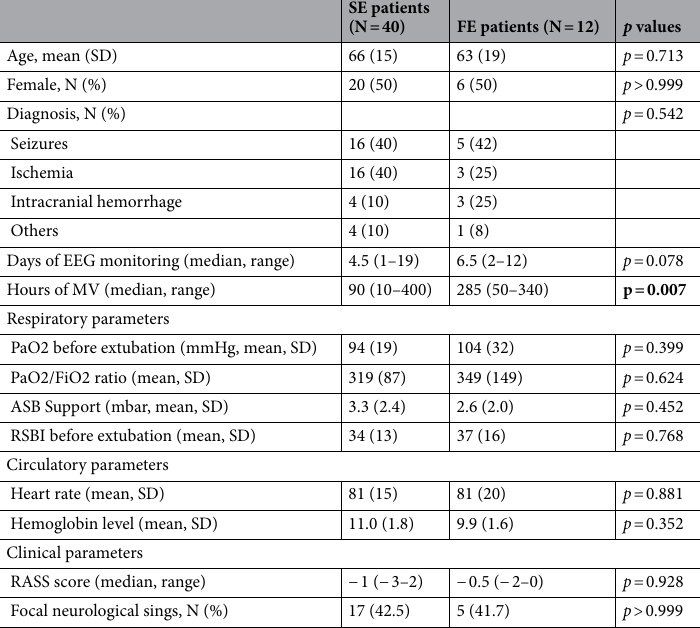
Table 1. Patients´ characteristics. ASB = assisted spontaneous breathing, FE = Failed extubation, FiO2 = fraction of inspired oxygen, MV = mechanical ventilation, mbar = millibar, mmHg = Millimeter of Mercury, N = number, PaO2 = arterial partial pressure of oxygen, RASS = Richmond Agitation Sedation Scale, RSBI = Rapid shallow breathing index, SD = standard deviation, SE = Successful extubation. Significant values are in